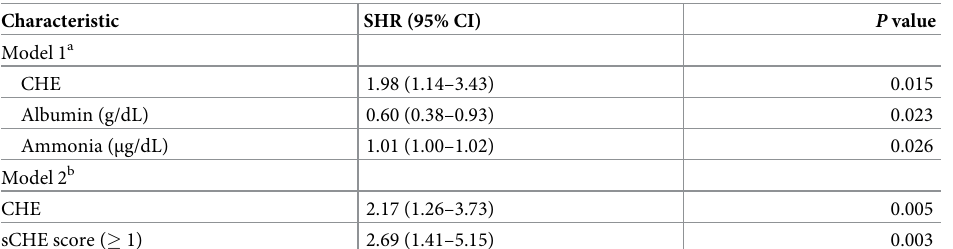
Table 3. Multivariate competing risk analysis to predict OHE in patients with cirrhosis. Characteristic Model 1